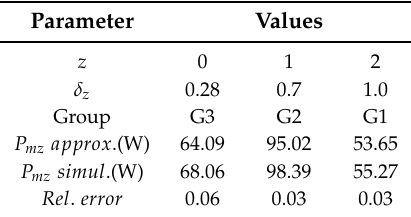
Figure 11. I–V and P–V behavior for diagonal shadow pattern in a PV module. Table 1. Maximum power points—Case: diagonal